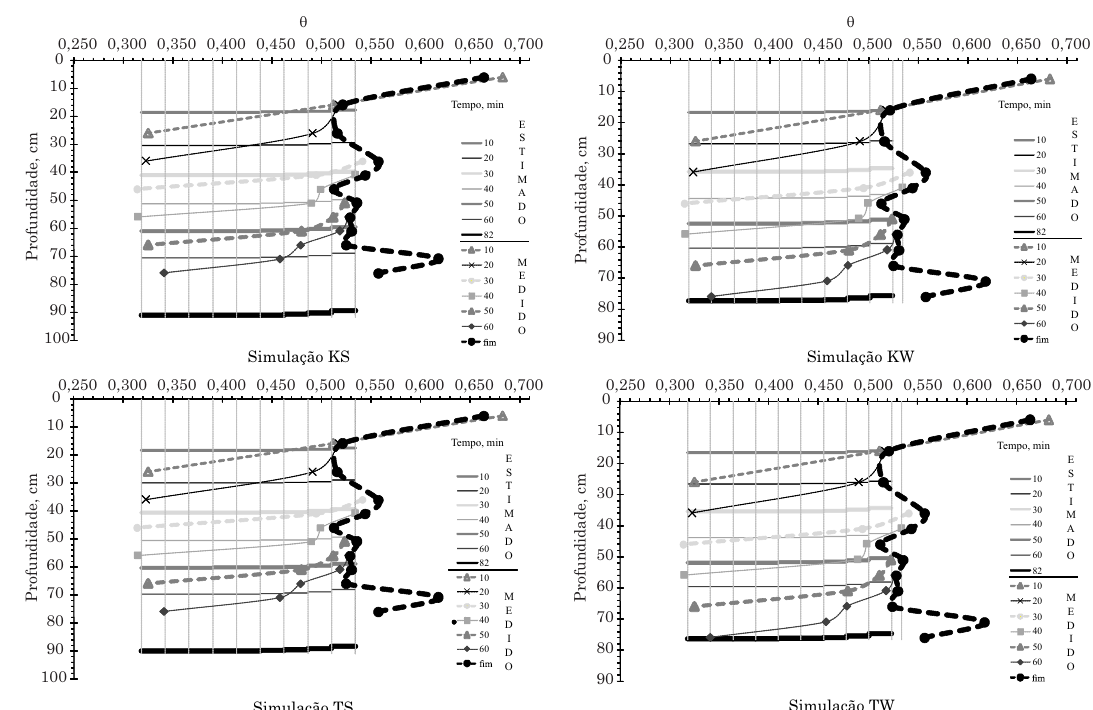
Figura 7. Perfis de umidade medidos e estimados com o GAML-c no 3º teste